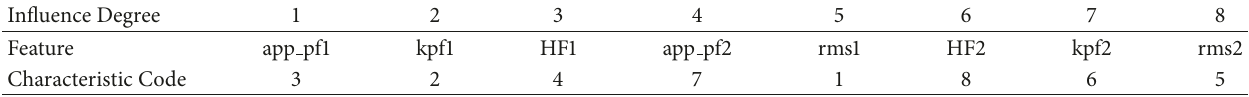
Table 3: SVM-RFE-MRMR feature ranked table.